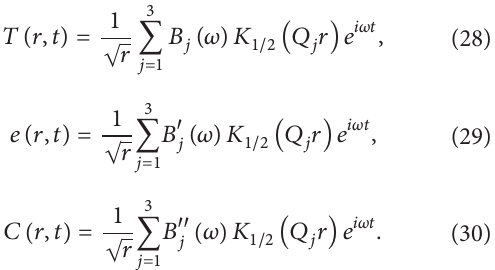
kind of order 1/2 . Compatibility between (26) along with (19) and (20) will give rise